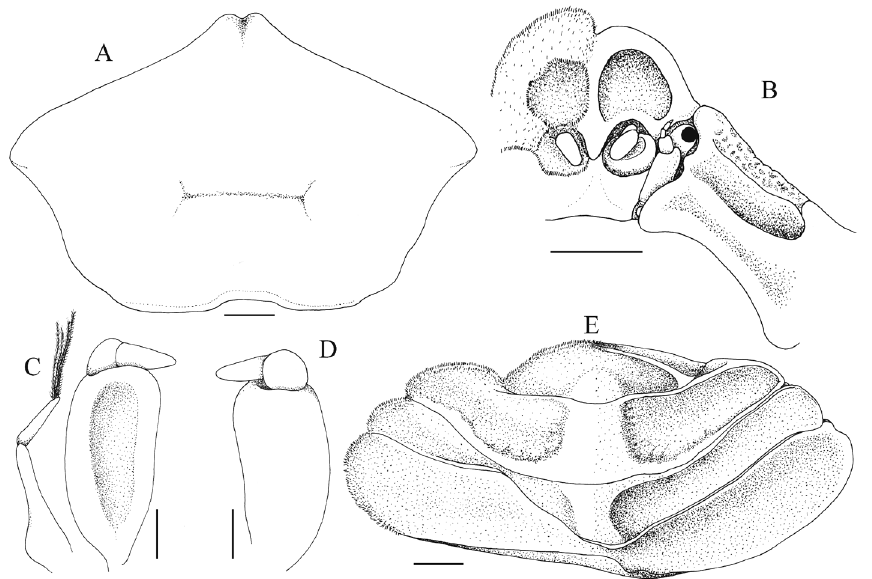
Figure 5. Serenotheres janus sp. n., holotype ♀ (8.9 × 7.9 mm) (USNM). A overall carapace dorsal lamellum B frontal view of cephalothorax (left side denuded) C outer view of right MXP3 and exopod (denuded) D inner view of right MXP3 (denuded) E abdominal somites 4–6 and telson (pits and eroded areas not drawn, left side denuded). Scales: A, B, E = 1.0 mm; C, D = 0.5